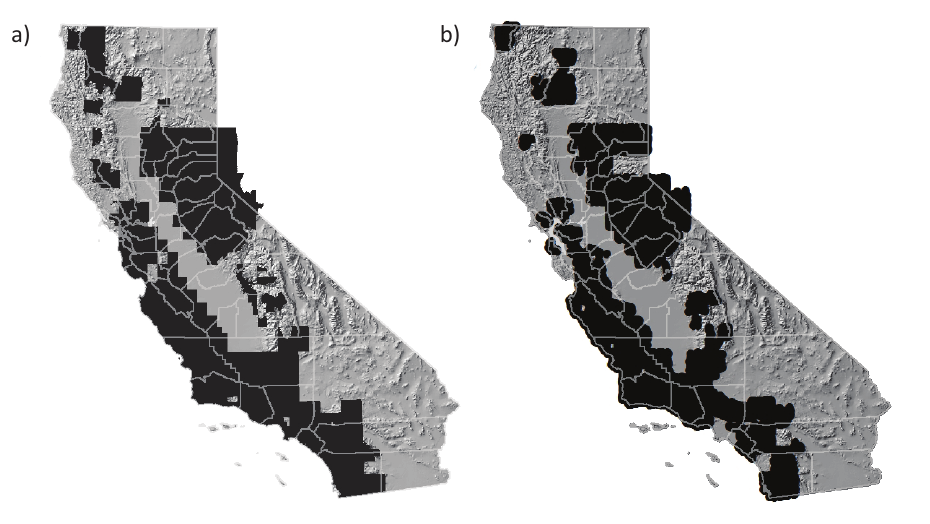
Figure 1. Locations of a) VTM vegetation maps and b) VTM vegetation plots in California.